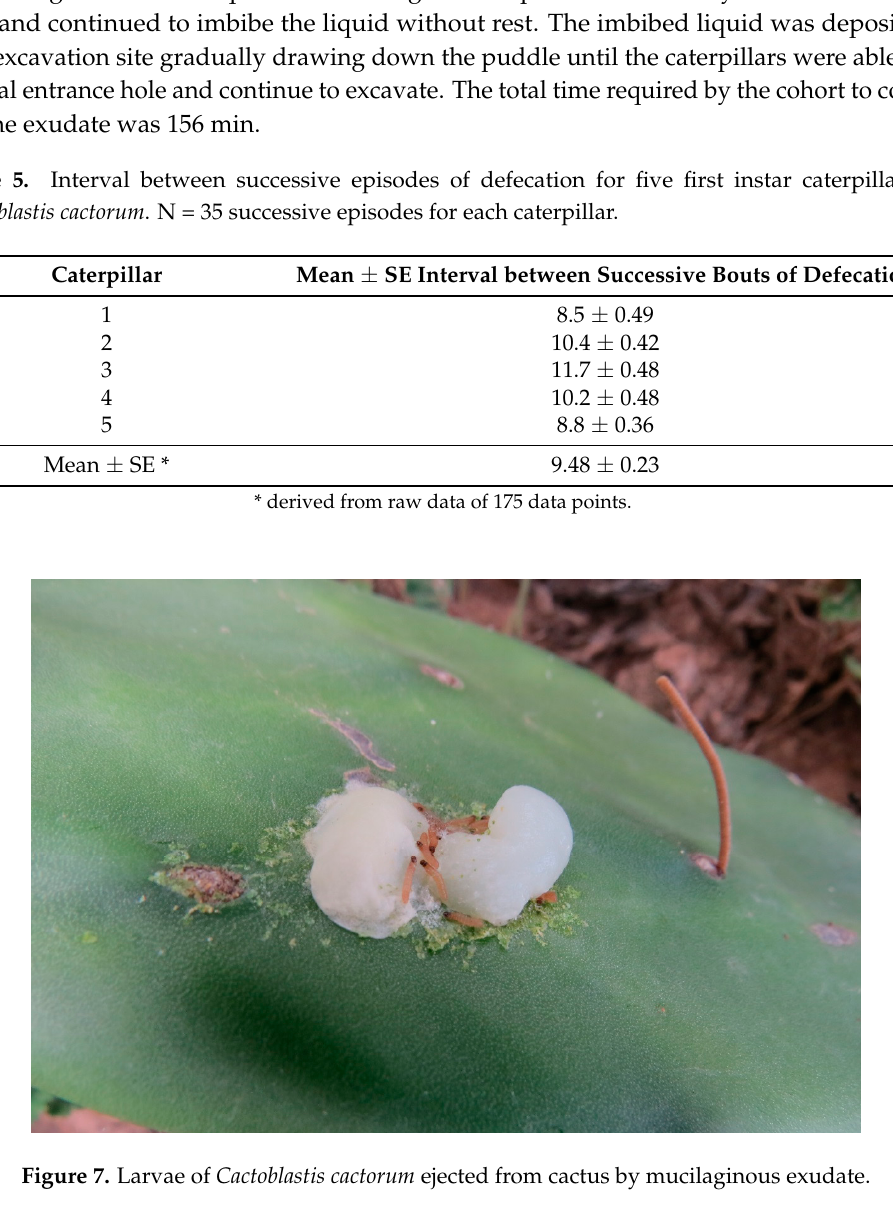
Table 5. Interval between successive episodes of defecation for five first instar caterpillars of Cactoblastis cactorum . N = 35 successive episodes for each